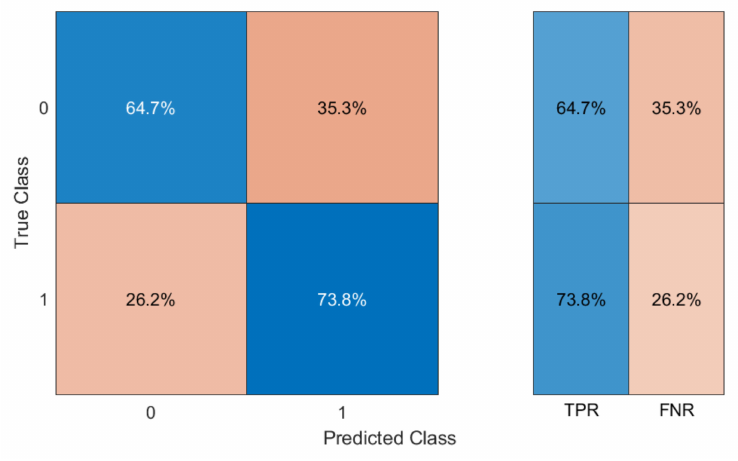
Figure 9. Confusion matrix for the classification of HDPE (class 0) and PP (class